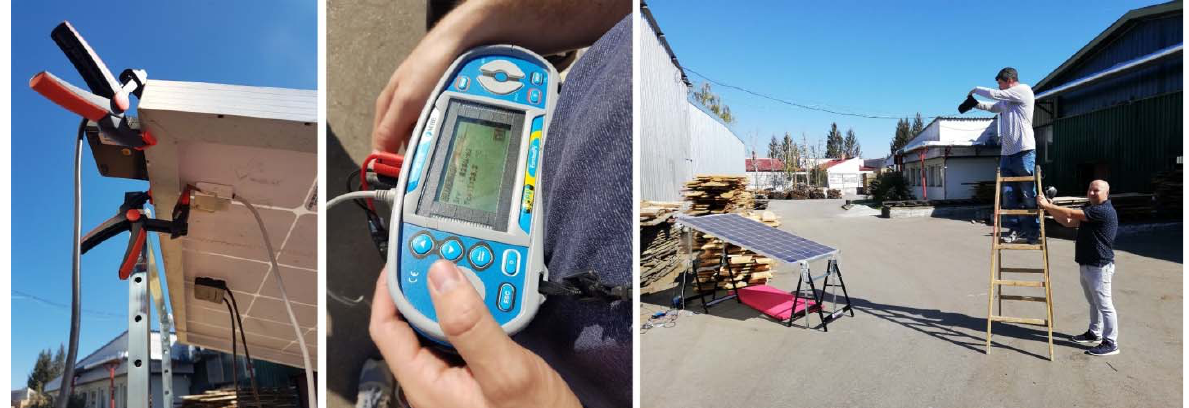
Figure 13. Photo documentation of the measurement procedure.